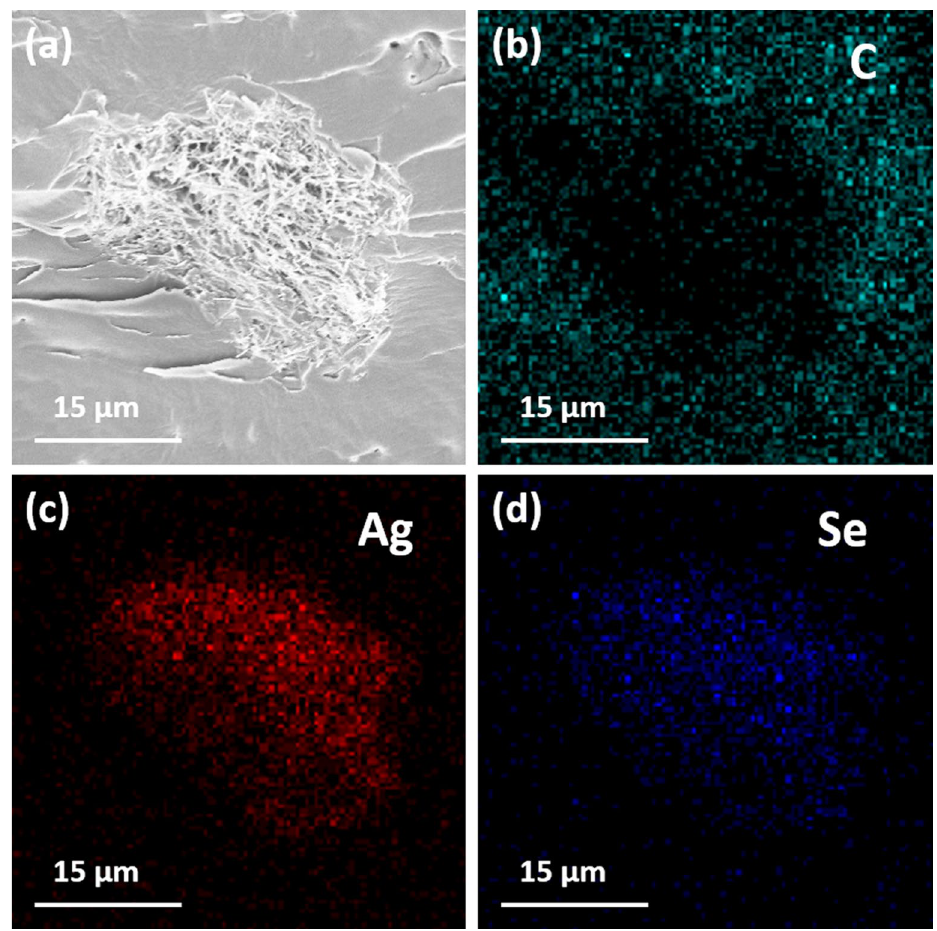
Figure 4. ( a ) Cross sectional FE-SEM images of AS30, and the corresponding EDS elemental mappings of ( b ) C, ( c ) Ag, and ( d ) Se atoms.